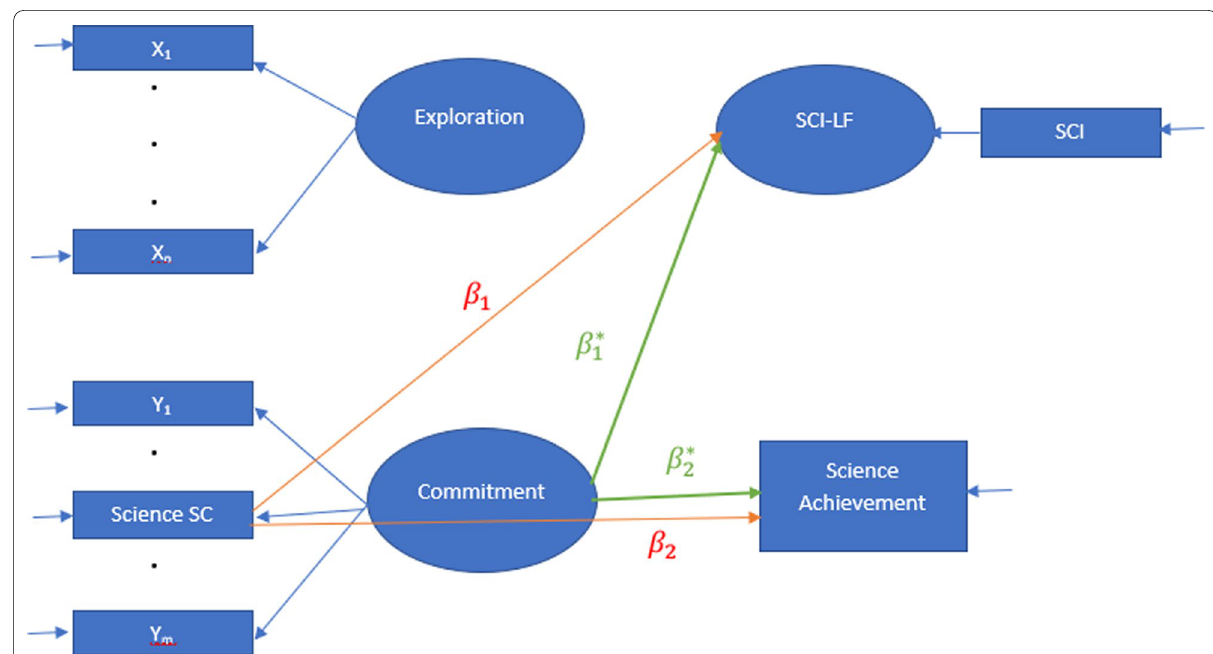
Fig. 2 Theoretical SEM illustrating the evaluation of equivalency for science self‑concept and science identity. Science SC view myself as a science person.”); Science Achievement—measured as a weighted variable based upon student academic success in science and the rigor of the science courses the student pursued); SCI‑LF composite score of the Science Subscale from the